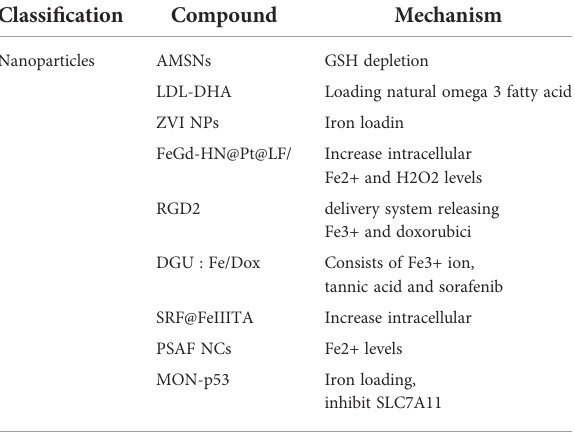
TABLE 2 This table lists nanoparticles currently known to induce or promote ferroptosis in the treatment of